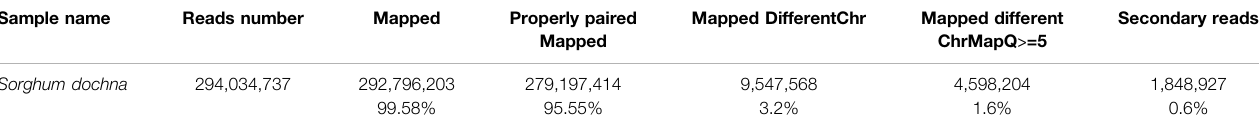
TABLE 2 | Statistics of the results of a comparison of the DNA library.